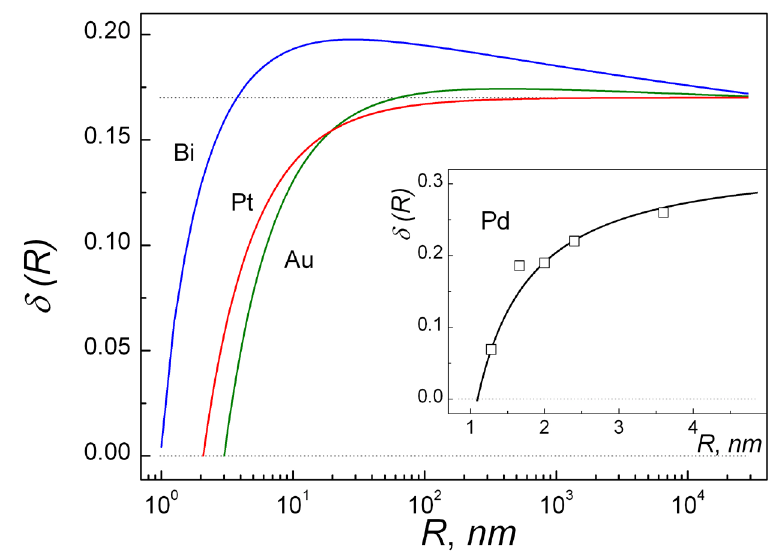
Figure 2. Relative thermal hysteresis as a function of the NP radius calculated by numerically solving Equation (10) for Bi: α 0 = 0.234, β 0 = 0.124, λ = − 0.033 , Au: α 0 = 0.37, β 0 = 0.08, λ = 0.06, Pt: α 0 = 0.29, β 0 = 0.087, λ = 0.02. Insert: solid line denotes the solution from Equation (10) with respect to Palladium (Pd) with δ 0 = 0.28, α 0 = 0.32, β 0 = 0.087, λ = 0. Symbols are the results calculated using the values of melting and solidification temperatures for nanoparticles obtained by molecular dynamics simulations [28].